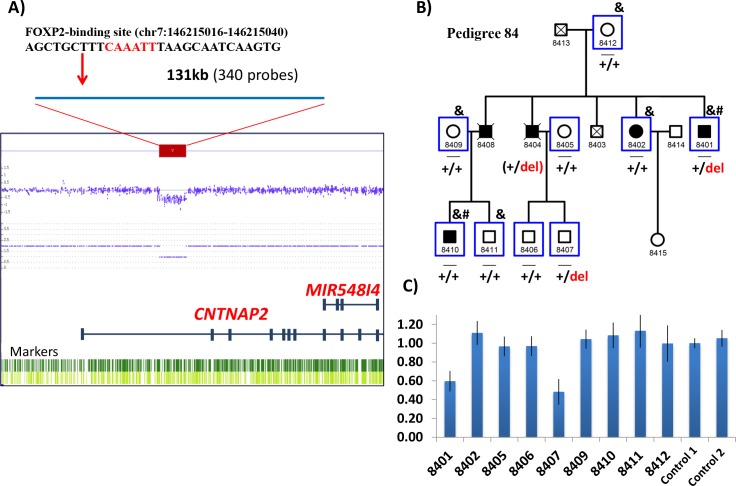
CNV deletion encompassing intron 1 of CNTNAP2 in an extended family with bipolar disorder.A) CytoScan HD array output image shows the position of the drop in signal intensity of 340 probes, indicating a deletion spanning 131kb (chr7:146203548–146334635; GRCh37/hg19) found in the patient 8401. The position of the FOXP2 binding site within the deletion is shown above. B) The bipolar pedigree includes five patients with bipolar disorder I (BPI) across two generations. Symbols: _, individuals with DNA available; &, individuals with whole exome data; #, individuals analysed for genome-wide CNVs through the CytoScan HD array; blue squares, individuals included in CNV qPCR validation and genotyping analysis, for which heterozygous deletion carriers are indicated as “+/del” and non-carriers are indicated as “+/+”. Inferred genotypes are in parentheses. C) Gene dosage results of the qPCR experiments validating the deletion in patient 8401, and showing the deletion in unaffected subject 8407.